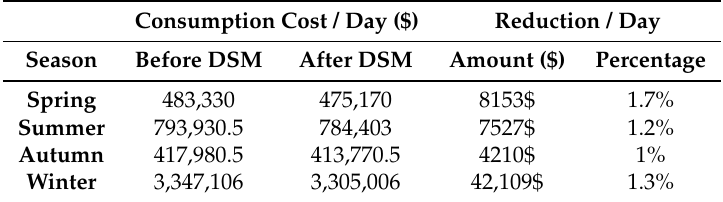
Table 5. Energy consumption cost reduction by the proposed DSM